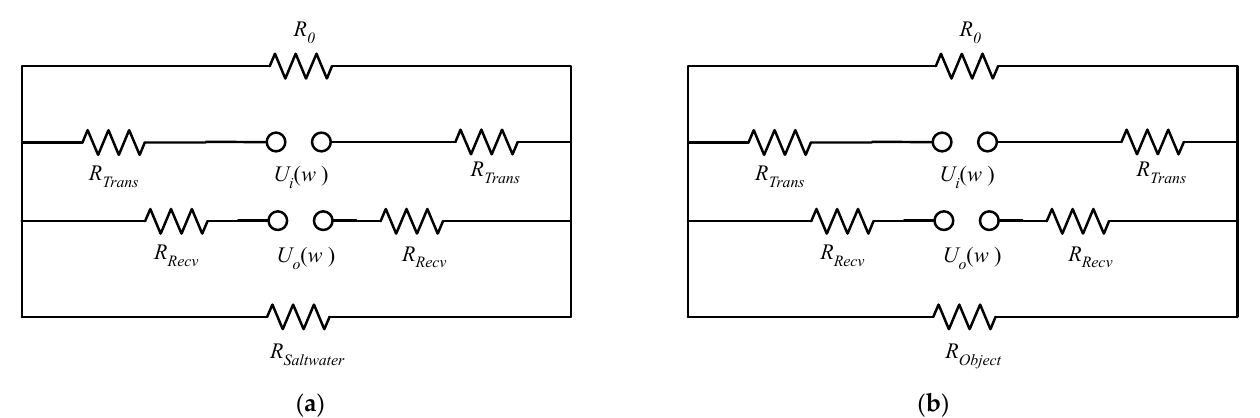
Figure 2. Equivalent circuits for the underwater active electrolocation system with and without an object in the vicinity. ( a ) Circuit without object. ( b ) Circuit with object.